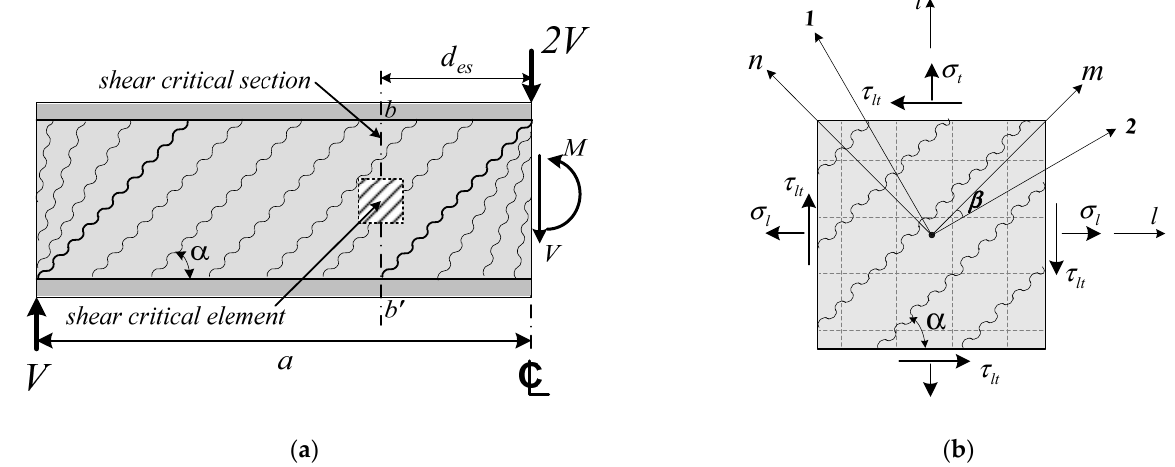
Figure 1. Shear critical element and coordinates of a RC beam: ( a ) RC beam; ( b ) shear critical RC element.